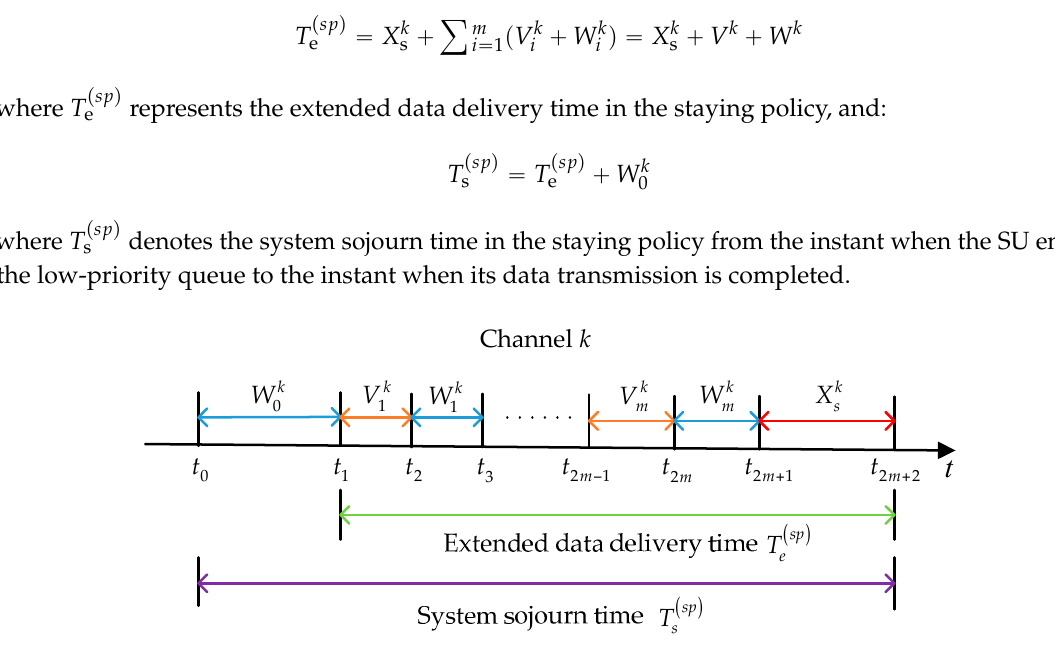
Figure 1. The behaviors of a secondary user (SU) under the staying policy in the preemptive repeat identical (PRI) M/G/1 queuing network model.